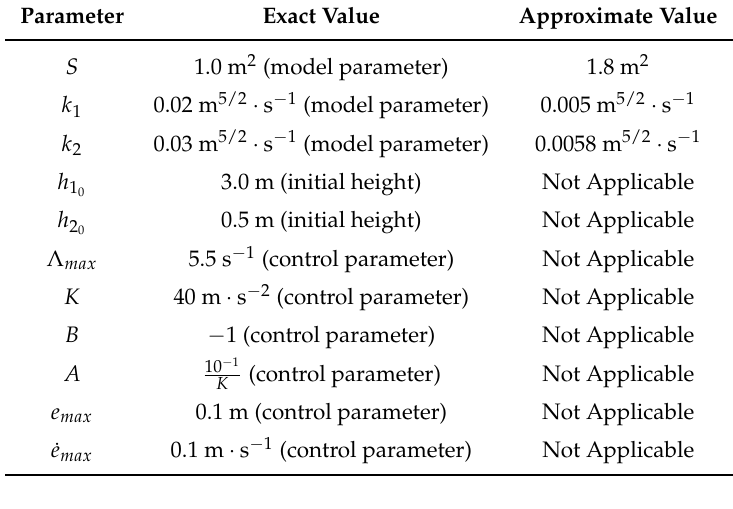
Table 1. The parameters used in the simulations.